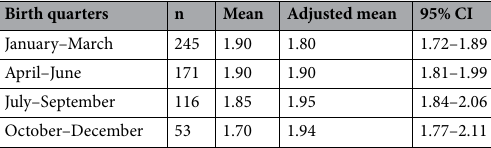
Table 5. Means and adjusted means of players’ efficiency